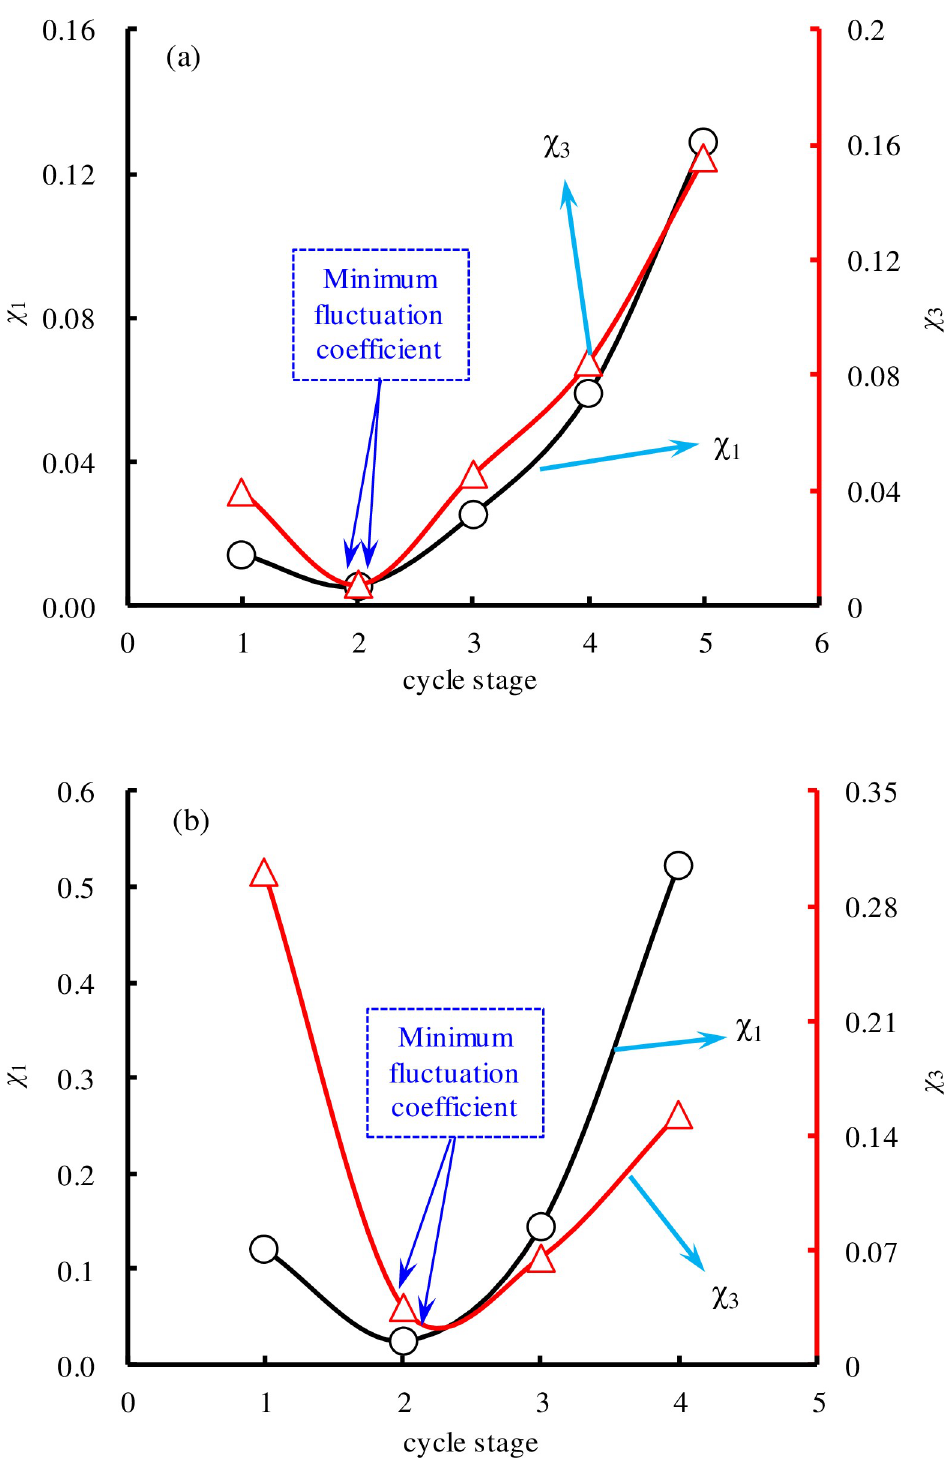
Fig 12. Fluctuation coefficient of dissipation energy in single cycle: (a) SS-1; (b) SS-2.